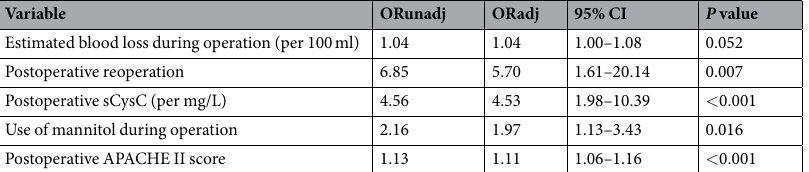
Table 4. Multivariable Logistic Regression Analysis of Factors that Are Related to Postoperative AKI in Neurosurgical Critically Ill Patients. Abbreviations: AKI, acute kidney injury; ORunadj, odds ratio unadjusted; ORadj, odds ratio adjusted; CI, confidence interval; Postoperative reoperation, reoperation within 7 days after the first neurosurgical operation; APACHE II, Acute Physiology and Chronic Health Evaluation; sCysC, serum Cystatin